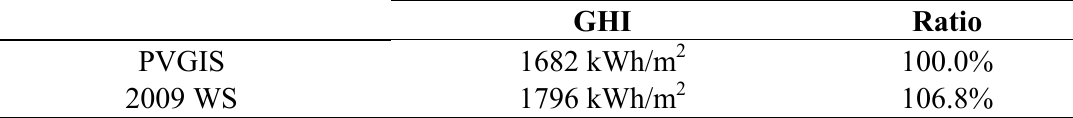
Table 5. PVGIS GHI, real GHI and their ratios at that Ciudad Real weather station in